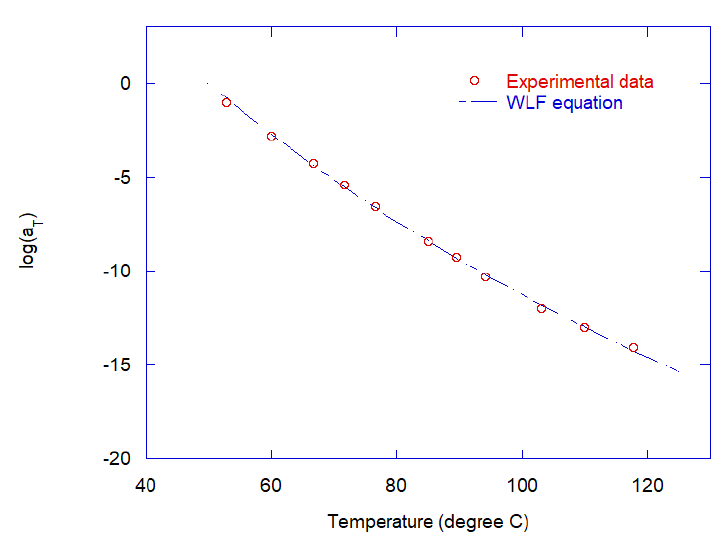
Figure 12. Shift factors of Polymer